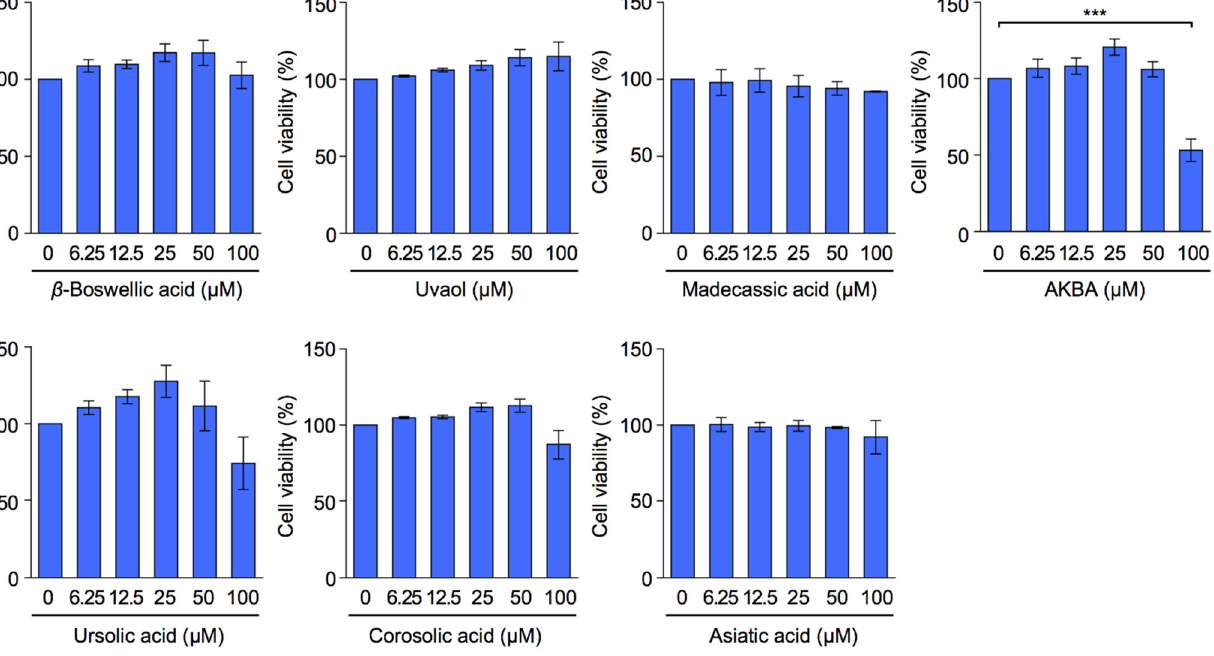
Figure 2. Effects of ursane-type pentacyclic triterpenoids on cell viability. A549 cells were incubated with serial dilutions of triterpenoids for 7 h at the indicated concentrations. Cell viability was evaluated by the MTT assay. Cell viability (%) is shown as the mean ± S.E. of three independent experiments. *** p < 0.001.